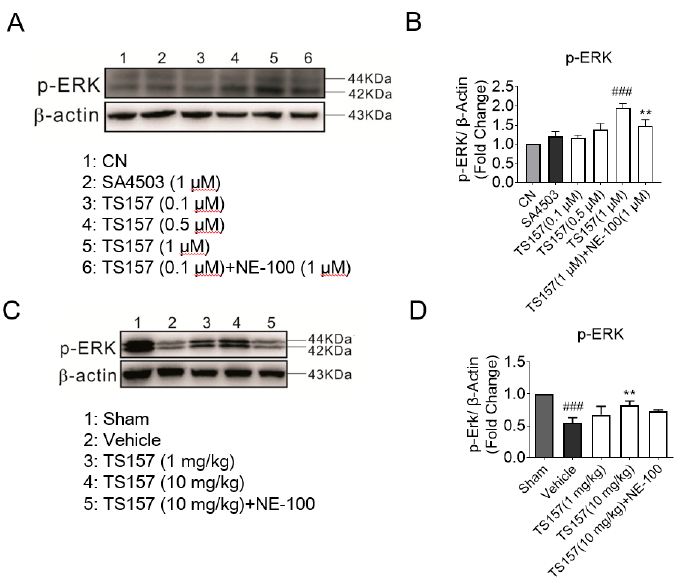
Figure 8. TS-157 can induce upregulation of pERK. ( A ) Western blot for pERK protein of N1E-115 cells with SA4503 (1 μ M), TS-157 (0.1 μ M, 0.3 μ M, 1 μ M), and TS-157 (1 μ M) plus NE-100 (1 μ M); ( B ) pERK/ β -Actin ratio of rats in above groups; ( C ) Western blot for brain penumbra protein of rats at 28th day after tMCAO in sham group, control group, TS-157 low-dose group (1 mg/kg), TS-157 high-dose group (10 mg/kg), and TS-157 high-dose plus antagonist group (TS-157, 10 mg/kg + NE-100, 10 mg/kg); ( D ) pERK/ β -Actin ratio of rats in above groups. Statistically significant differences: ** p < 0.01, ### p < 0.001 vs. vehicle (one-way ANOVA followed by Bonferroni test).